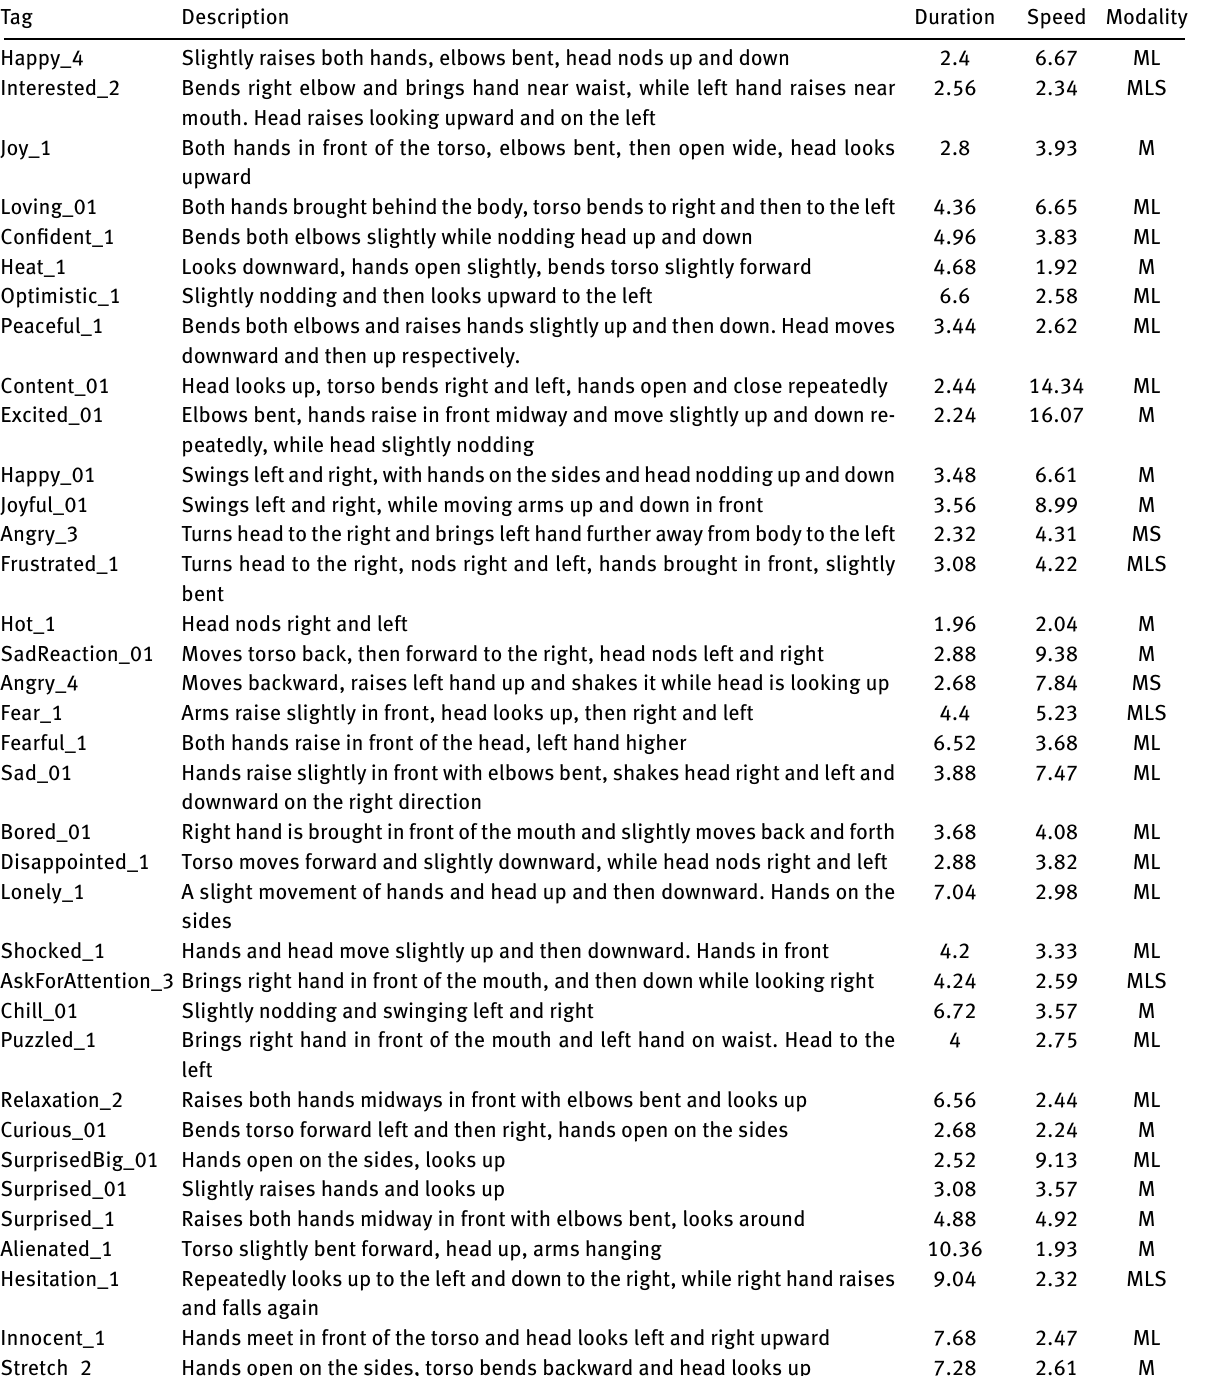
Table 4: Informal descriptions and properties of the animations: categorical tag for the identification of the animation (assigned by the animators during the creation phase), informal descriptions of the movements displayed, duration of the animation in seconds, speed calculated as total frames divided by key frames, and modalities coded as M = Motion, L = LEDs, S =